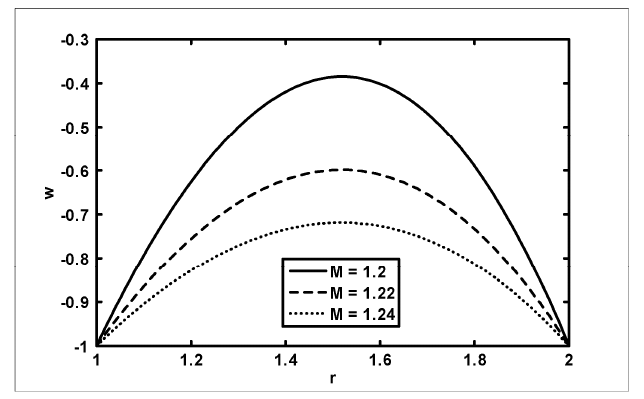
= Figure 13. Velocity profiles for di ff erent values of M at t = 1, z = 1, ϕ = 1, when µ = 1 . r when 1 μ . r